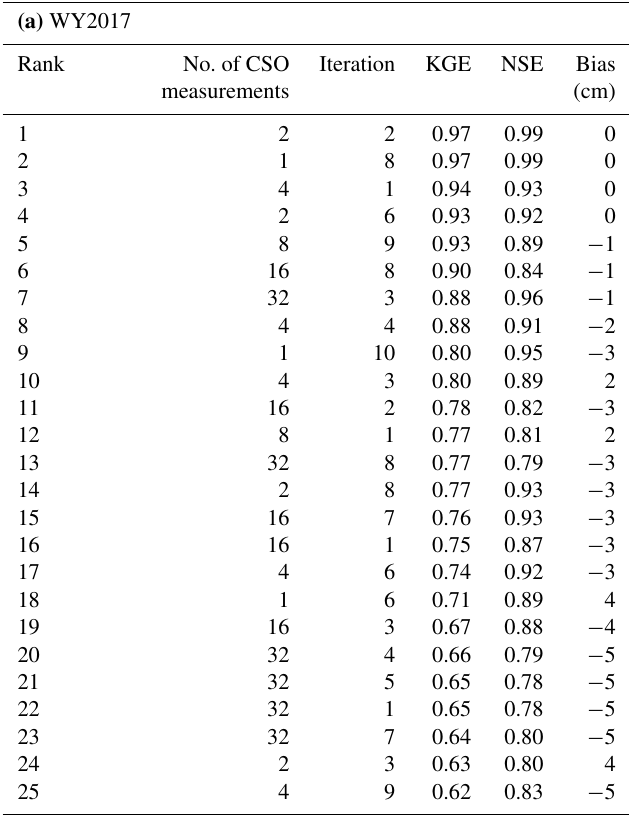
Table E1. Ranked temporal results. Ensemble results from ranked by Kling–Gupta efficiency (KGE) score for water year (WY) 2017 (a) and WY2018 (b) . Also included are the Nash–Sutcliffe efficiency (NSE) and the mean bias error (bias)